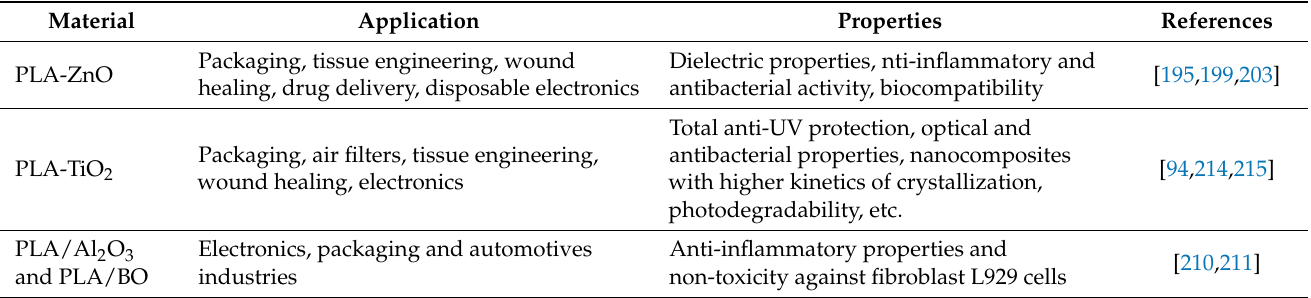
Figure 16. Filtration performance of FM1 (containing 0 wt.% TiO 2 prepared at a relative humidity of 45%), FM2 (containing 1 wt.% TiO 2 prepared at a relative humidity of 45%), FM3 (containing 1.75 wt.% TiO 2 prepared at a relative humidity of 45%), FM4 (containing 1.75 wt.% TiO 2 prepared at a relative humidity of 15%), and FM5 (containing 1.75 wt.% TiO 2 prepared at a relative humidity of 60%) at various face velocities: ( a ) filtration efficiency, pressure drop, and quality factor of FM1, FM2, and FM3 at a face velocity of 5.3 cm/s and 14.1 cm/s, respectively and ( b ) filtration efficiency, pressure drop, and quality factor of FM3, FM4, and FM5 at a face velocity of 5.3 cm/s and 14.1 cm/s, respectively [213]. Table 4. Applications of PLA/metal-oxide nanocomposites in various